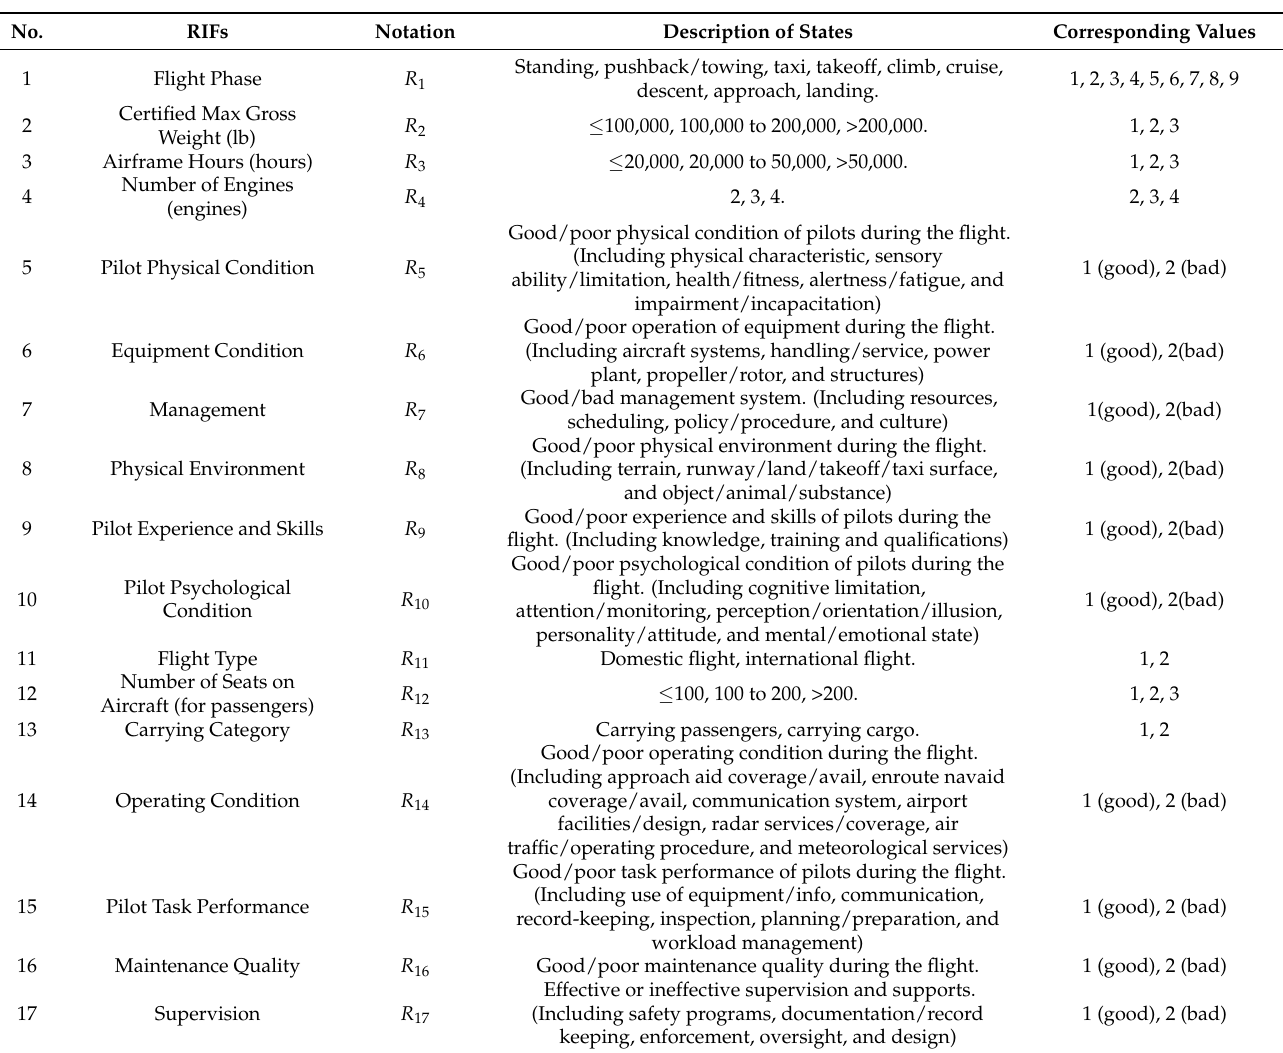
Table 2. RIFs defined in civil aviation